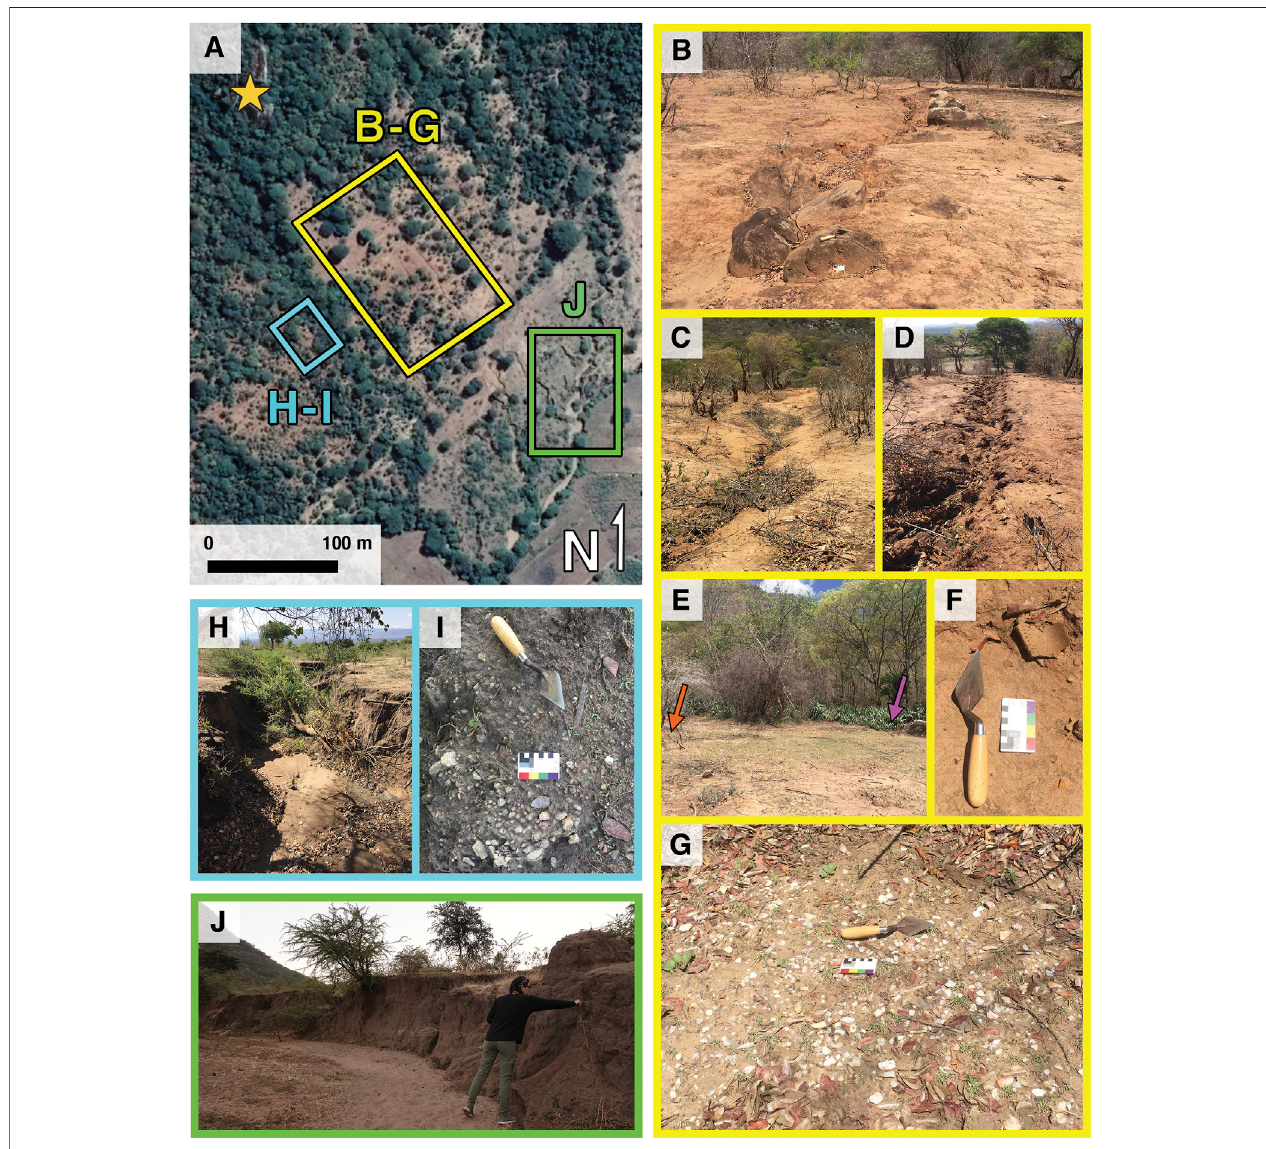
FIGURE4| ImagesoferosionalfeaturesaroundtheKiseseIIsite. (A) Satelliteimagesofthesite(ESRIWorldImagery:MaxarImagery,2018).Thelocationofthesite is marked with a star. The three areas bounded by rectangles indicate the location of the photographs in (B – G) . (B) rill forming right below the site with small boulders, embedded in the red paleosol, being exposed by the erosion of the yellow regosol. (C , D) progression of erosion and rill carving between our 2017 and 2018 survey seasons.Note the complete removal oftheyellowregosoland theenlargement oftherill. (E – G) scatters ofstonetools and potterybeing exposed and transported downhill.Arrowsin (E) showthepositionofthescattershownin (G) andarowofsisalplantstotheright.Asmentionedinthetextsisalplantswereplantedasastrategyto combatslopeerosion.However, theycreateaverylimited and localized barriertoerosion aswewitnessed in thiscase wherethe scatter ofstone tools positioned onlya few meters from it is still being impacted by colluvial activity. (H – J) show the more drastic effects of erosion. (H) shows the large gully, indicated in Figure 2 , that starts immediately south of the site and runs downhill until the valley. Along the gully we have found scatters of stone tools, such as the one shown in (I) . (J) Area where three different gullies coalesce into a